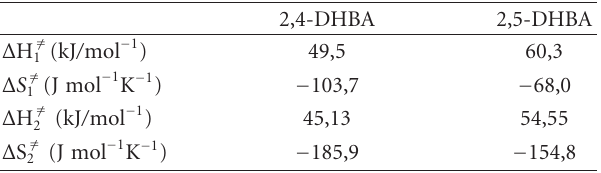
Table 2: Activation parameters for steps 1 ( k 1 ) and 2 ( k 2 ) for the reactions of the two ligands 2,4- and 2,5-DHBA with